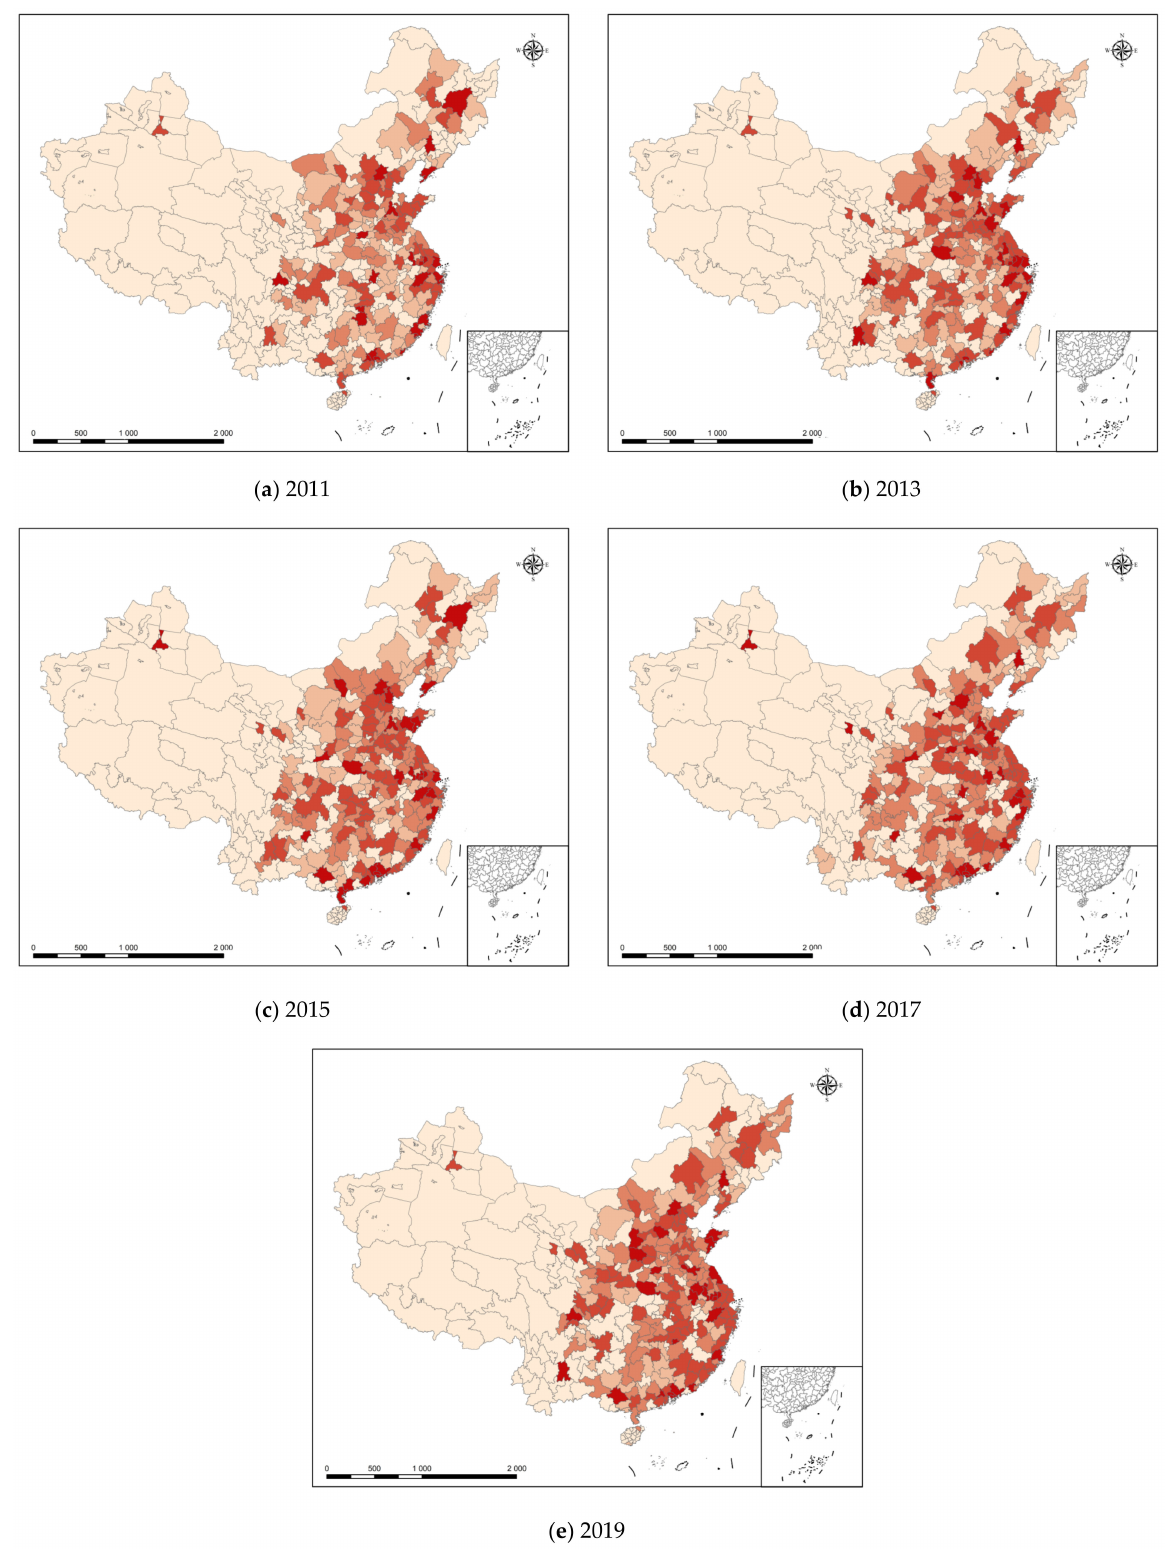
Figure 1. Spatial Distribution of the National Green Productivity Indexes